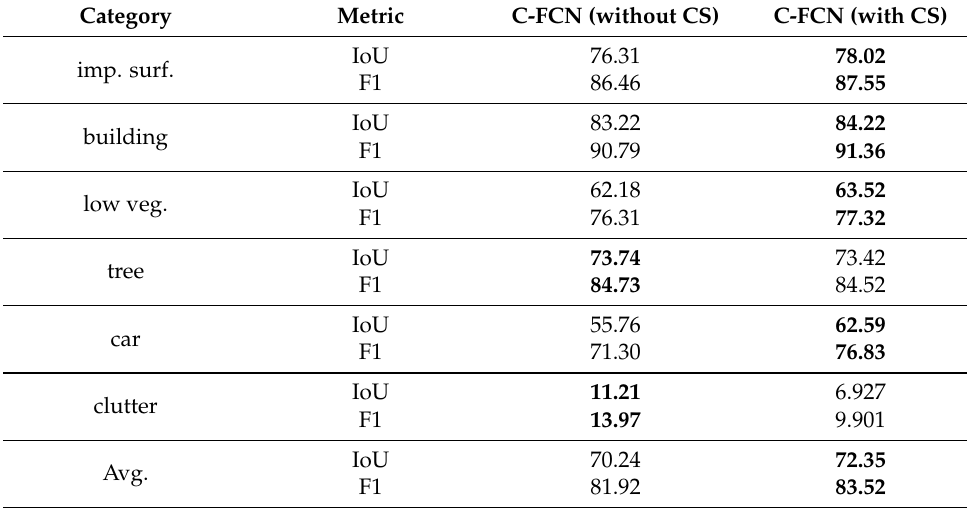
Table 3. Comparison experiments on CS module, measured by mean F1-score (%) and mean IoU (%) of all test